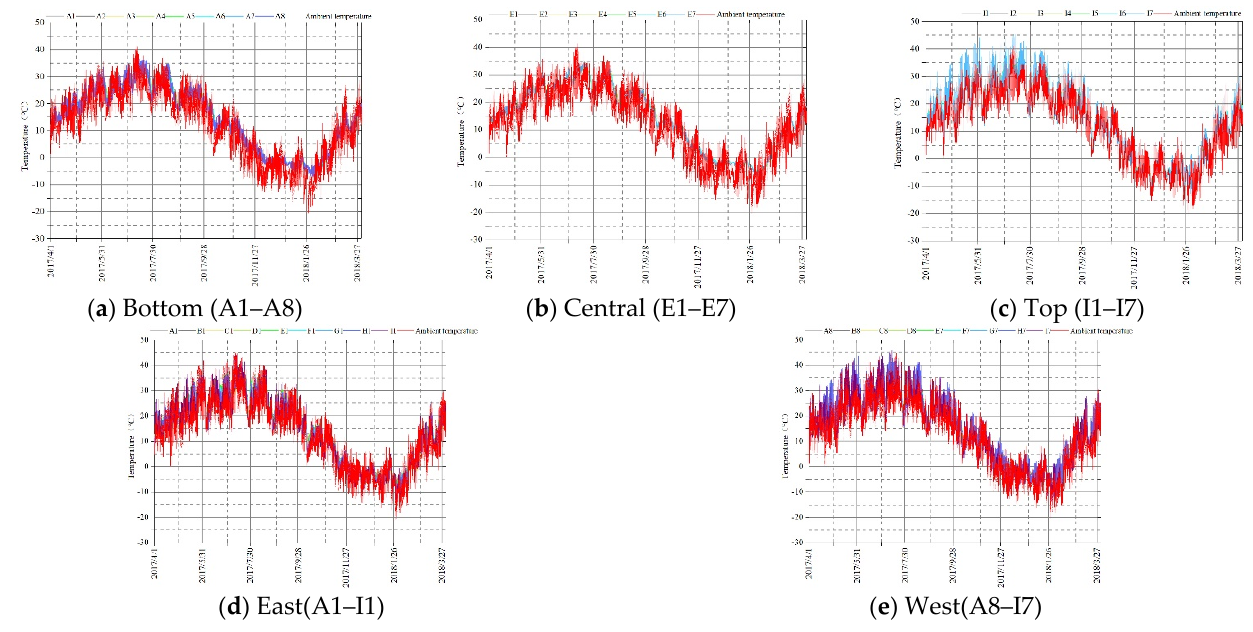
Figure 20. Wall temperature-atmospheric temperature relationship (1 April 2017–31 March 2018). As can be seen from Figure 19, the temperature changes on the east and west sides of the wall were the same as those of the atmosphere, but the surface temperature of the wall changed rapidly. Within one year, the maximum temperature of the atmospheric environment was 41.24 ◦ C, whereas the maximum temperature on the west side of the wall was 46.99 ◦ C. The maximum temperature on the east side of the wall was 44.20 ◦ C, which was 2.96 ◦ C higher than the atmospheric temperature. The lowest atmospheric temperature was − 20.5 ◦ C. The lowest temperature on the west side of the wall was − 15.2 ◦ C, which was 5.3 ◦ C higher than the atmospheric temperature, the lowest temperature on the east side of the wall was − 15.4 ◦ C, which was 5.1 ◦ C higher than the atmospheric temperature. The maximum atmospheric temperature difference was 61.74 ◦ C within one year, and the maximum temperature difference of the wall was 62.39 ◦ C. The temperature of the east wall was not obviously warmer than the atmospheric temperature, while the temperature of the west wall was almost always higher than the atmospheric temperature, which was directly related to solar radiation. As can be seen from Figures 20–26, the changes in temperature at the bottom, middle, top, east, and west of the wall showed the same trends as that of the atmospheric temperature. However, the overall trend had a certain lag, which was no more than 6 h. As can be seen from Figure 20, there were severe wall temperature changes (from strong to weak) in the top, west, east, bottom, and middle areas. Along the vertical direction of the wall, the sensitivity of temperature to environmental influences, from strong to weak, ranged from the top to the middle and then to the bottom. Within one year, the highest temperature at the top of the wall was 46.99 ◦ C, the lowest temperature was − 15.3 ◦ C, and the temperature difference was 62.29 ◦ C. The highest temperature at the bottom of the wall was 37.3 ◦ C, the lowest temperature was − 5.9 ◦ C, and the maximum temperature difference was 43.2 ◦ C. The highest temperature in the middle was 35.8 ◦ C, the lowest temperature was − 5.6 ◦ C, and the maximum temperature difference was 41.4 ◦ C. Along the horizontal direction of the wall, the temperature change was more severe in the west than in the east, and it was relatively stable in the middle. The annual maximum temperature difference on the west side was 62.6 ◦ C, the maximum temperature difference on the east side was 60 ◦ C, and the maximum temperature difference in the middle was 36.8 ◦